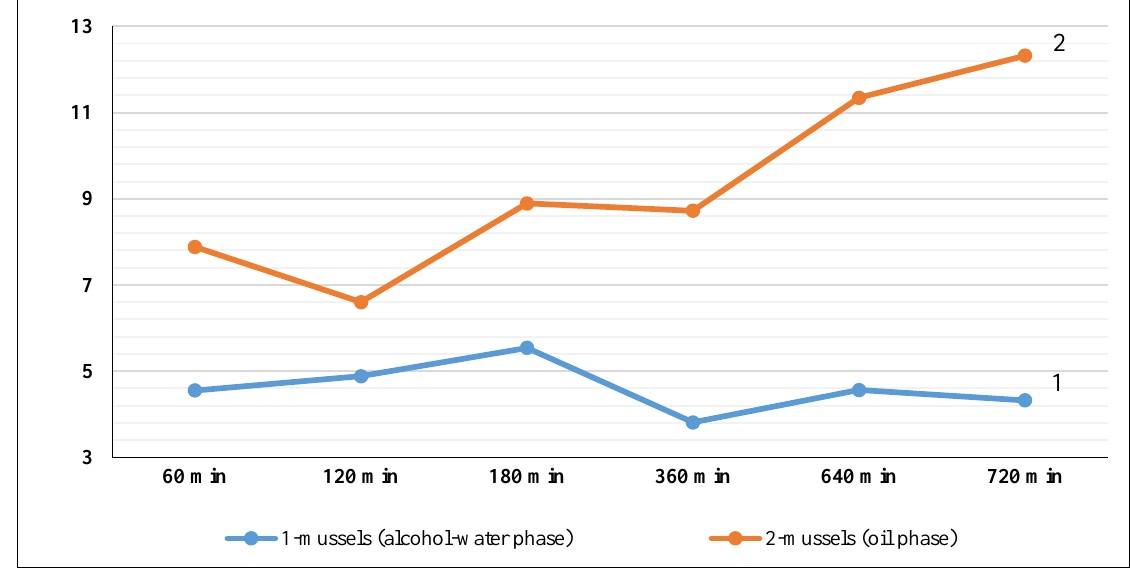
Figure 4. Antioxidative activity of BAS complexes from mussels, in the alcohol-water and oil phases (in terms of the amount of biologically active substances with antioxidative properties,